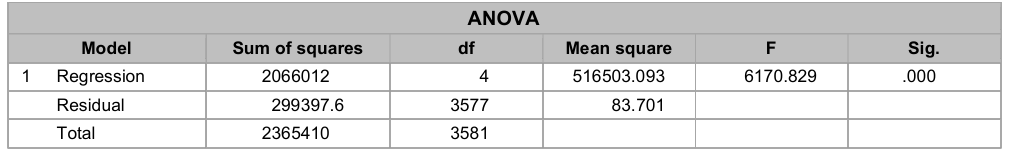
One-way analysis of variance (ANOVA) for managerial jobs ANOVA Sum of squares df Mean square